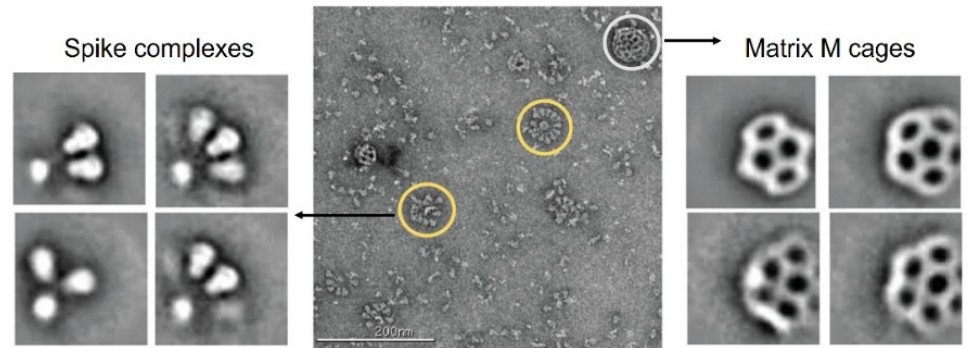
Figure 14. COVID-19 vaccine development through self-assembly of stabilized, full-length SARS- CoV-2 S protein subunits into nanoparticles. Negative stain electron microscopy of the full-length spike (reconstituted in PS 80) admixed with the cage-like Matrix-M component (from plant origin). The spike rosettes are circled in yellow, and Matrix-M adjuvant cages are circled in white. Reprinted from [206], with permission from American Association for the Advancement of Science.